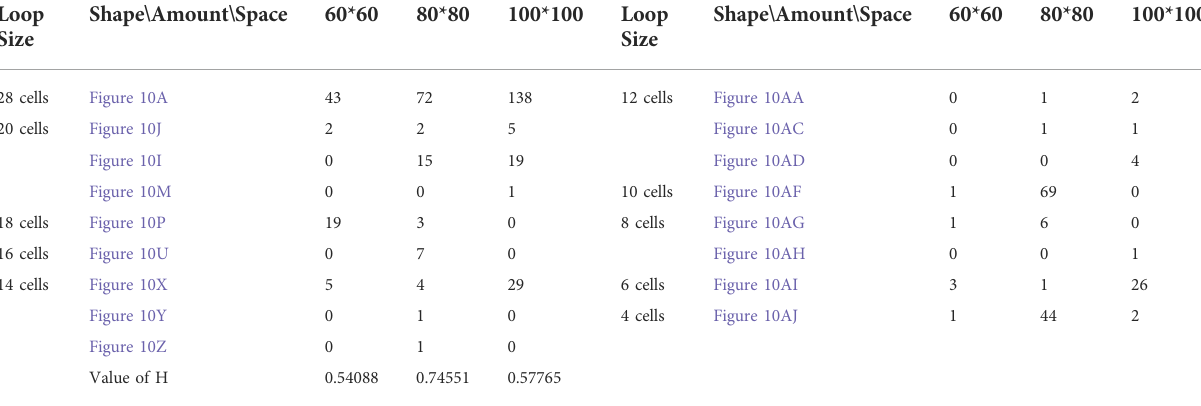
TABLE 10 Statistical numbers of the loops with various structures for the changing mechanism on different cellular spaces starting from the initial con fi guration in Figure 7C. Loop Shape ∖ Amount ∖ Space Size